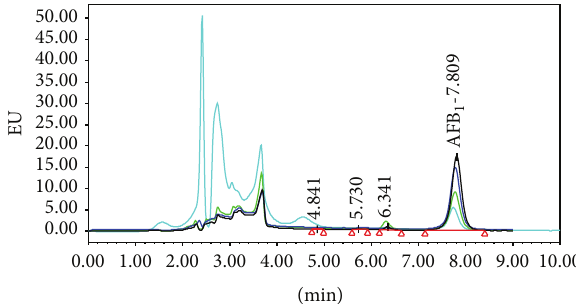
Figure2:ItshowstheHPLCchromatogramofAFB 1 (5ng/mL)after incubation with MRS at different pH